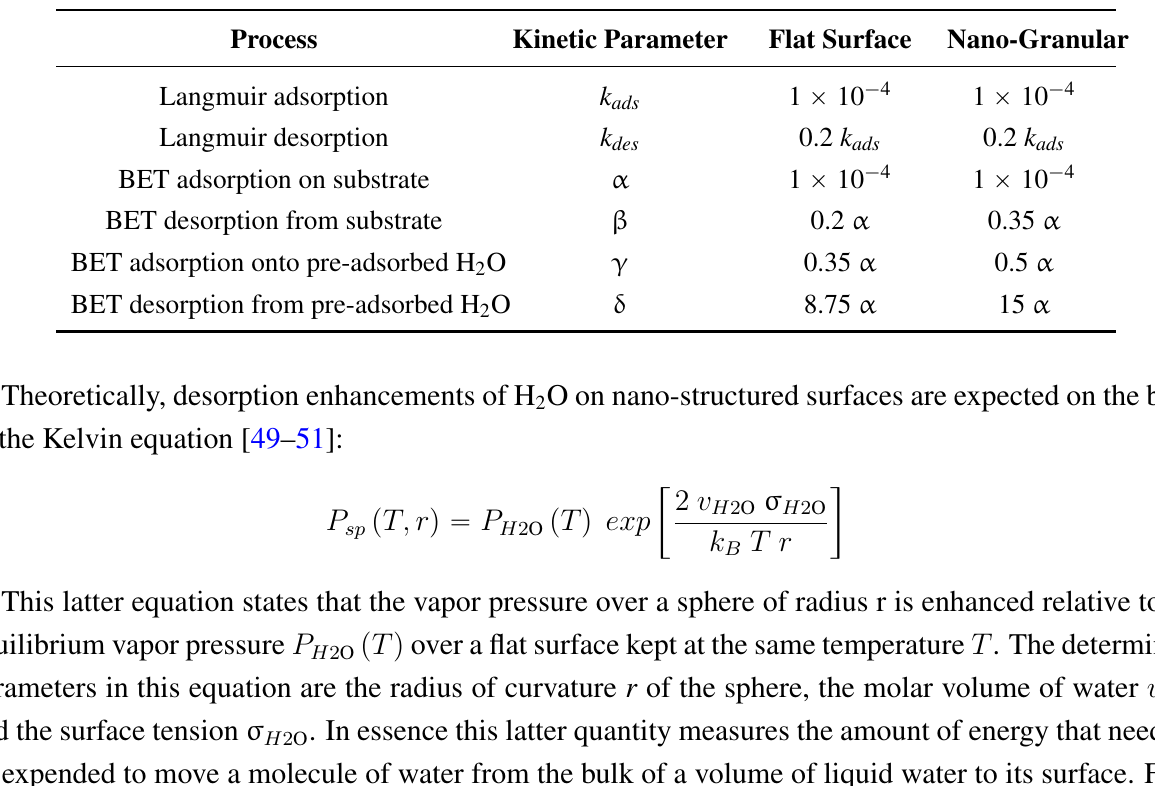
Table 1. Kinetic parameters for Langmuir and BET adsorption and desorption processes obtained from the data fits in Figure